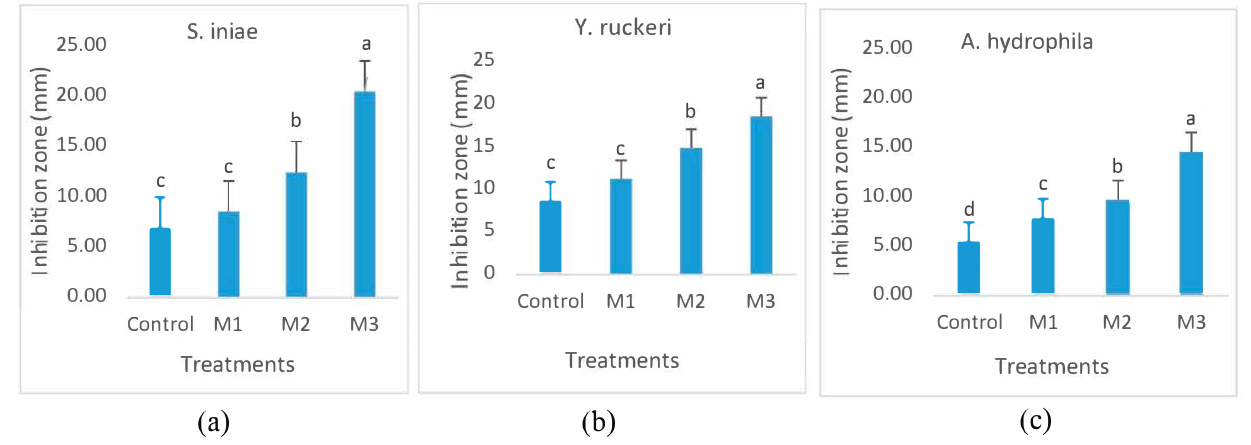
Figure 3. Antibacterial effects of skin mucus of C. carpio fed a basal diet incorporated with zero (control), 0.5% (M1), 1% (M2), and 2% (M3) of Myristica fragrans for four weeks against Streptococcus iniae ( a ), Yersinia ruckeri ( b ), and Aeromonas hydrophila ( c ) using the standard disk diffusion assay. Values were measured via ImageJ software in millimeters. Different subscripts indicate significant differences ( p < 0.05).